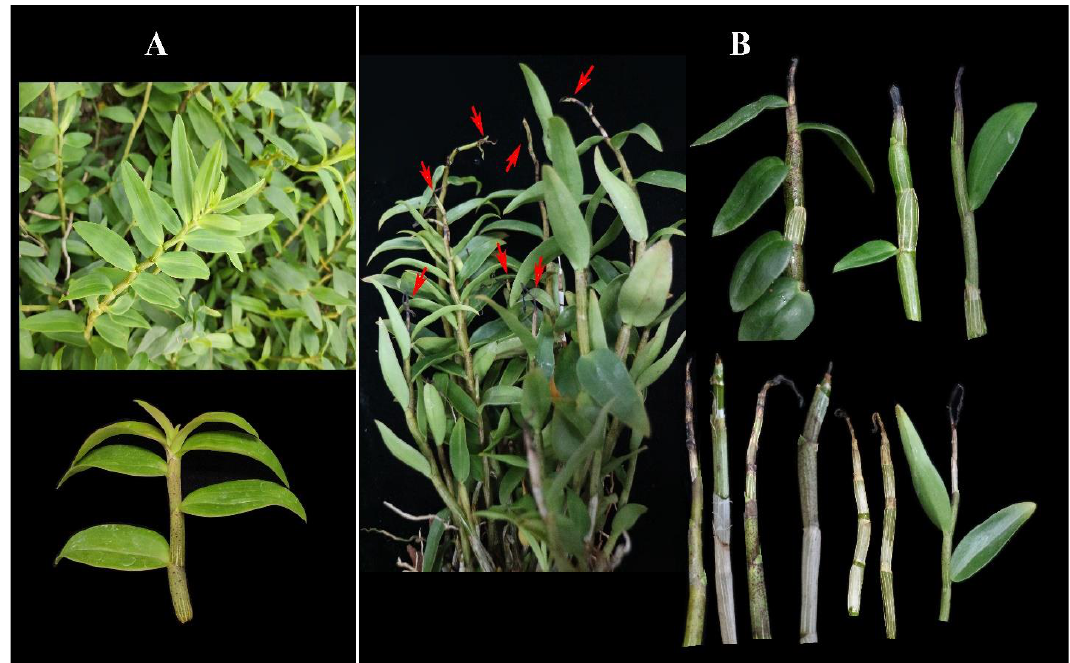
Table 2. Sampling details, number of isolates collected, and frequency of fungal species identified in the present study.